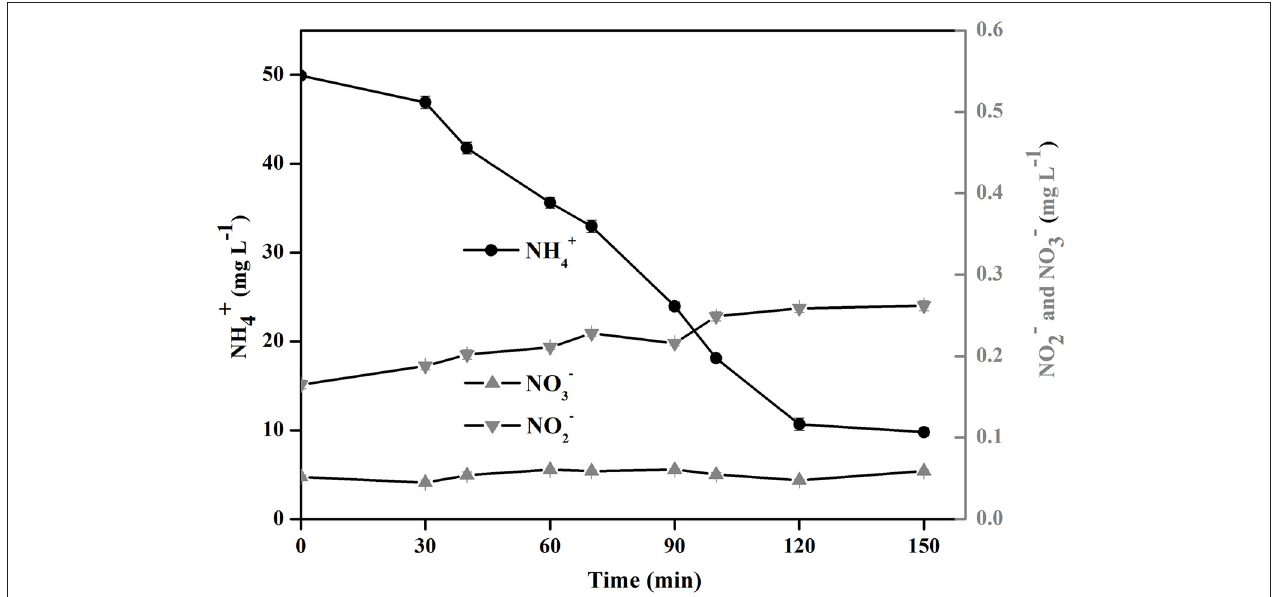
FIGURE 8 | Fate of NH + 4 -N, NO − 2 -N, and NO − 3 -N using Cu/ZnO/rGO for the photocatalytic oxidation of ammonia.